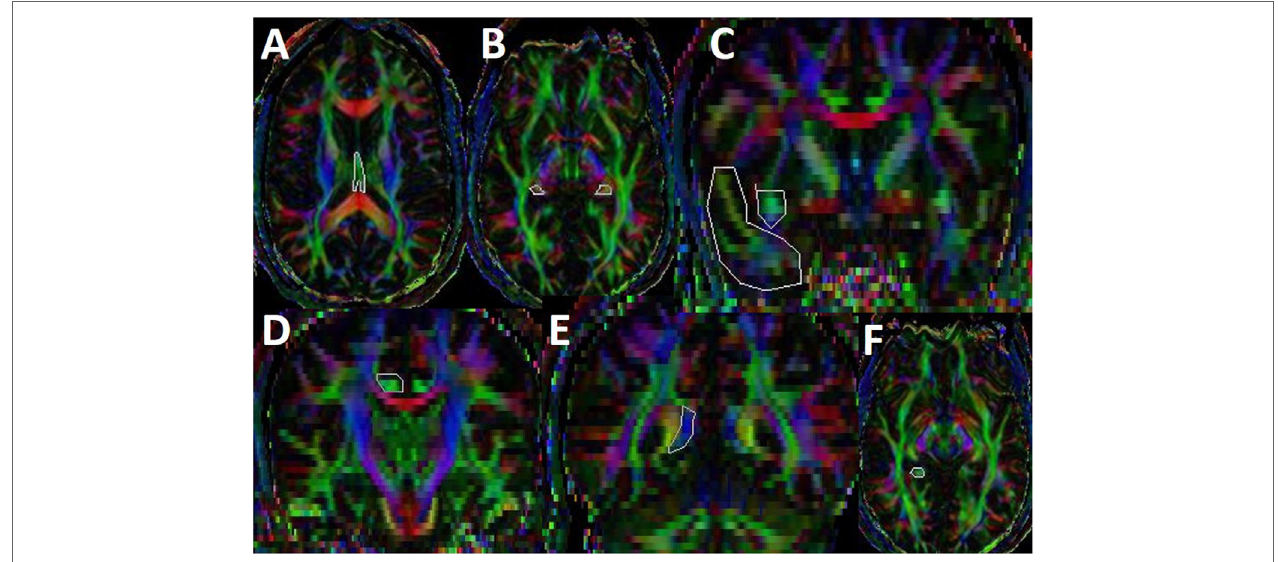
FigUre 2 | Illustration of fiber tractography in color-coded diffusion tensor imaging map. For fornix, we have seeded first ROI in subcallosal green fibers seen in axial slice where body and crus of fornix can be observed (a) and second and third ROIs are seeded in the mid and distal parts of crus (B) (35). For uncinate fasciculus (UF), we have seeded first ROI in the coronal section of temporal lobe and second ROI in the superomedial green projections fibers at the anterior commissure level (c) (34). For cingulum, we have seeded first ROI and second ROI in supracallosal green projection fibers anteriorly (D) and posteriorly (e) . Third ROI was seeded in the green hippocampal cingulum fibers seen in the medial temporal lobe (F) (4). Once a fiber tract was reconstructed, its entire trajectory was verified on a slice-by-slice basis to compare with established anatomical landmarks described in the human brain neuroanatomy atlases